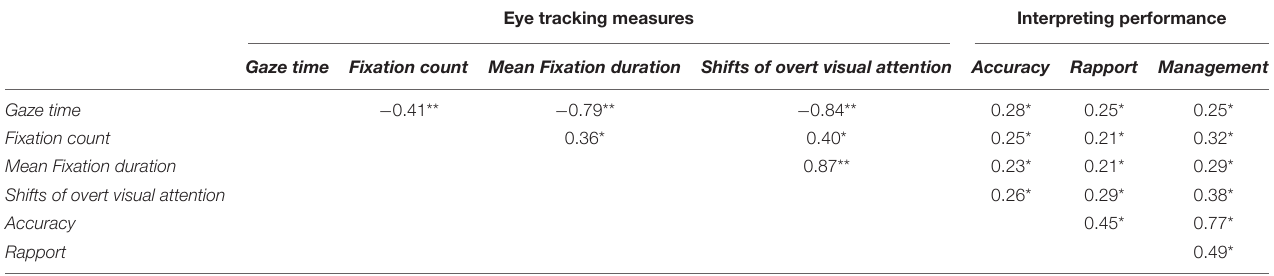
TABLE 3 | Pearson’s r correlation coefficients between eye tracking measures and interpreting performance. Eye tracking measures Interpreting